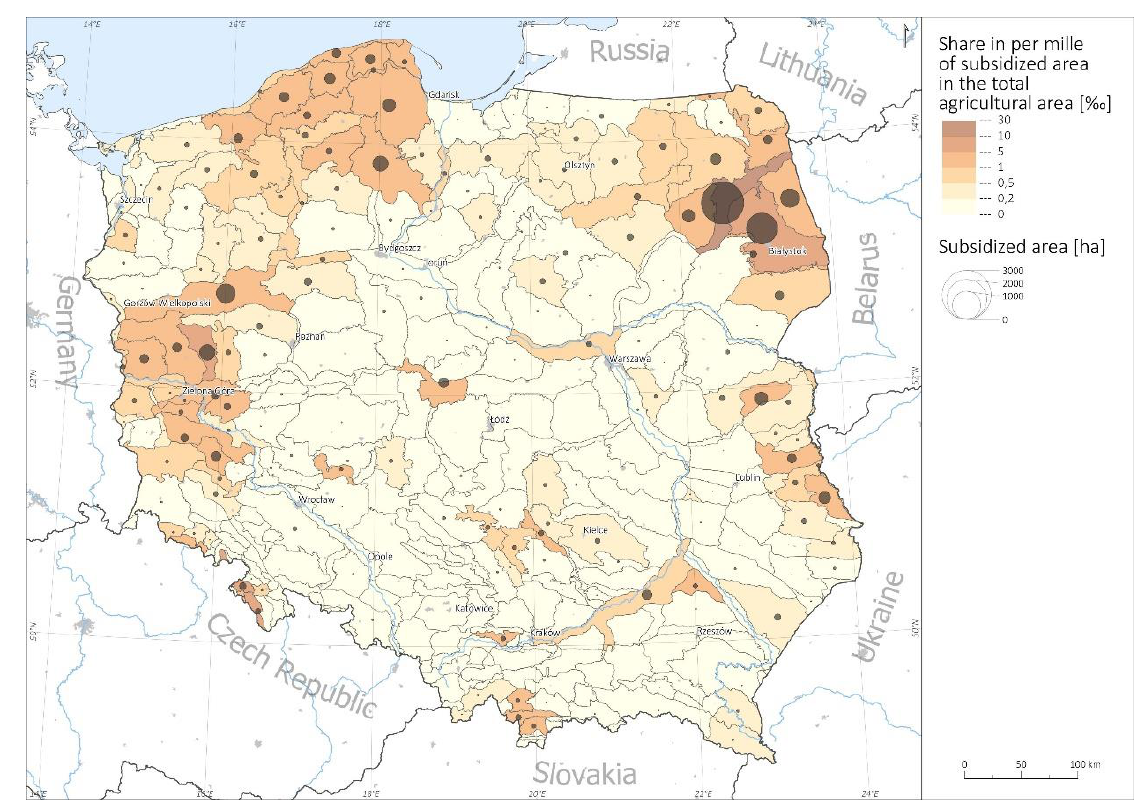
Figure 8. Area of land subsidised to support the protection of peat bogs and their share in the total area of agricultural land in mesoregions (Source: Authors based on ARMA data).